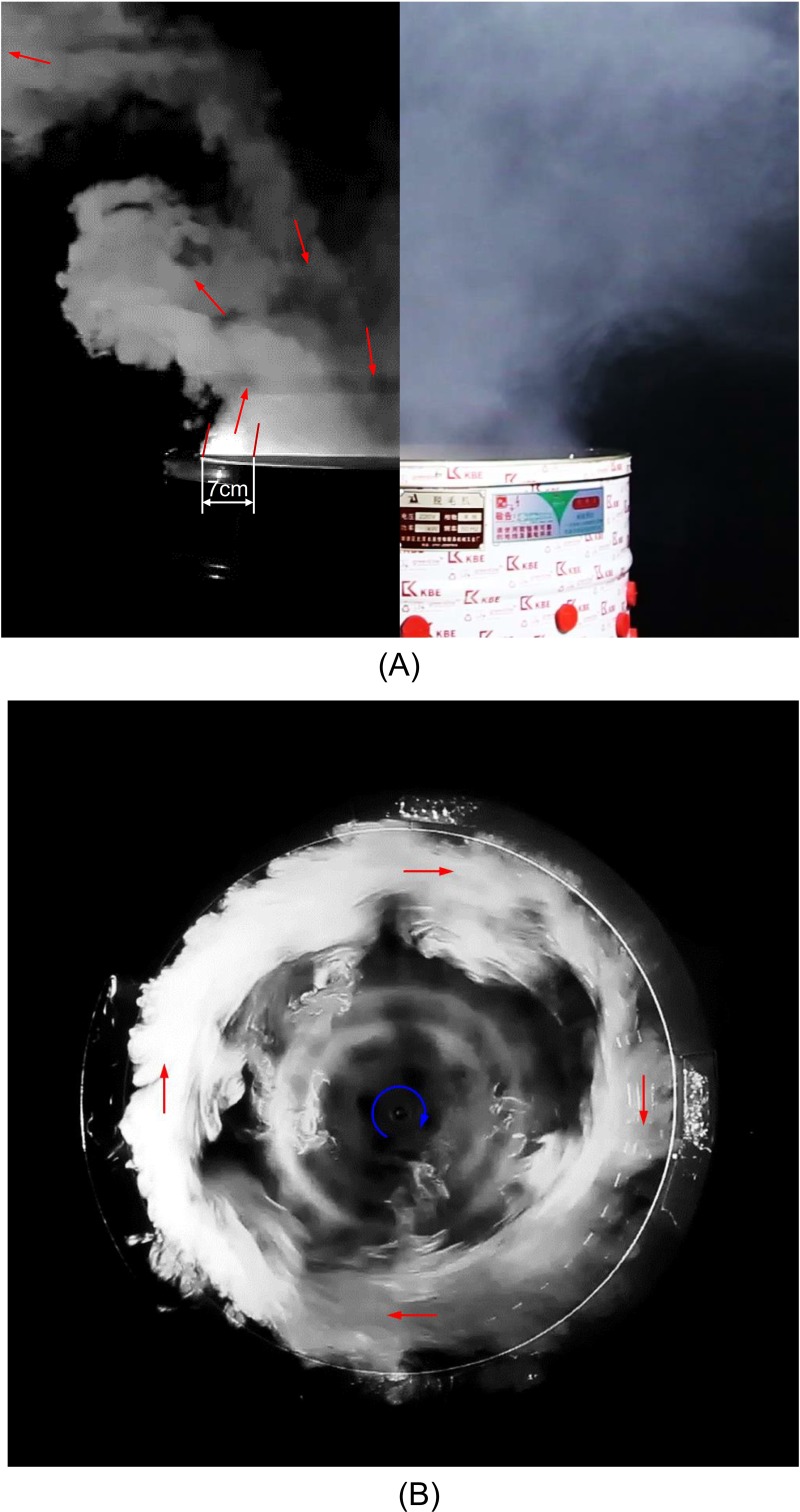
Visualisation of the air pattern above the mechanical defeatherer.(A) side view, illuminated by the laser sheet (left) or by the lamps (right) and (B) top view, illuminated by the laser sheet.